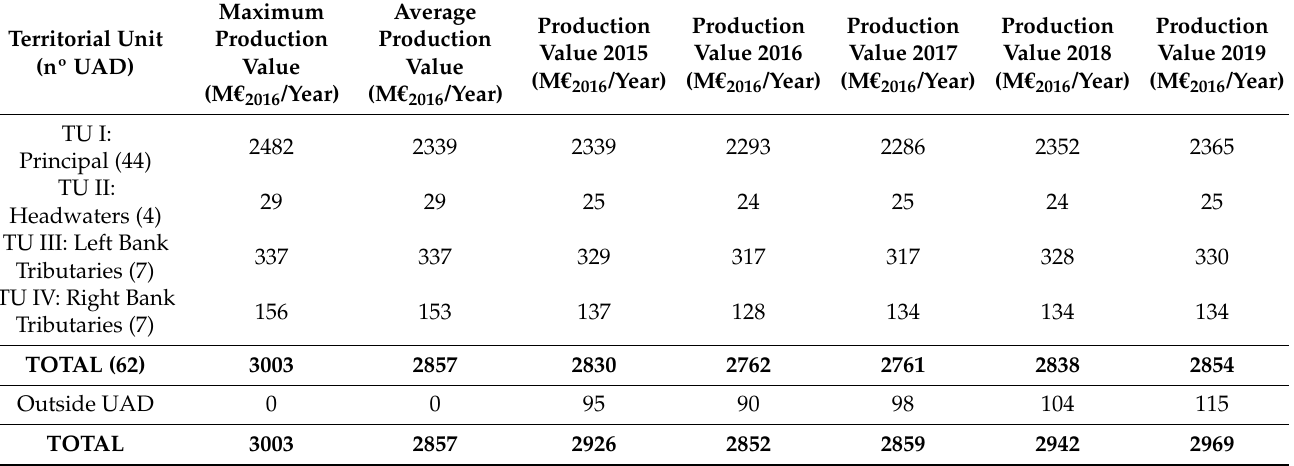
Table 18. Evolution of the value of production 2015–2019. Source: [42] based on Hydrological Planning Office of the Segura Hydrographic Confederation